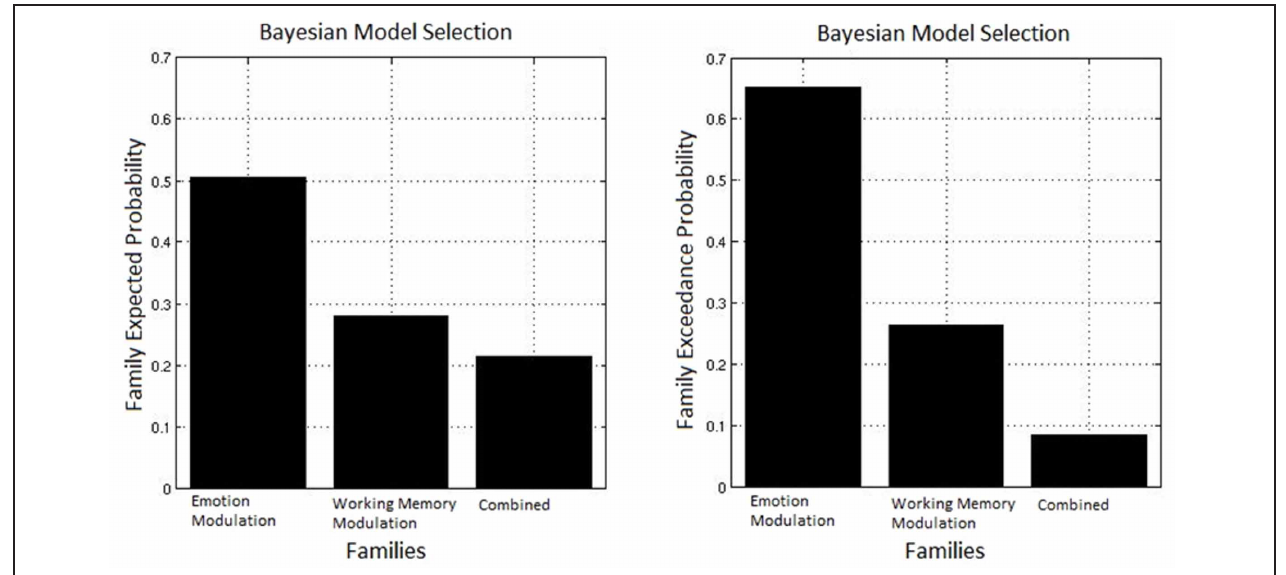
FIGURE 7 | Bayesian model selection for families. The Emotion Modulation family displayed the greatest exceedance probability, favoring models where connections between top-down nodes and the amygdala were modulated over ones with modulation of connections between top-down and task-related nodes.